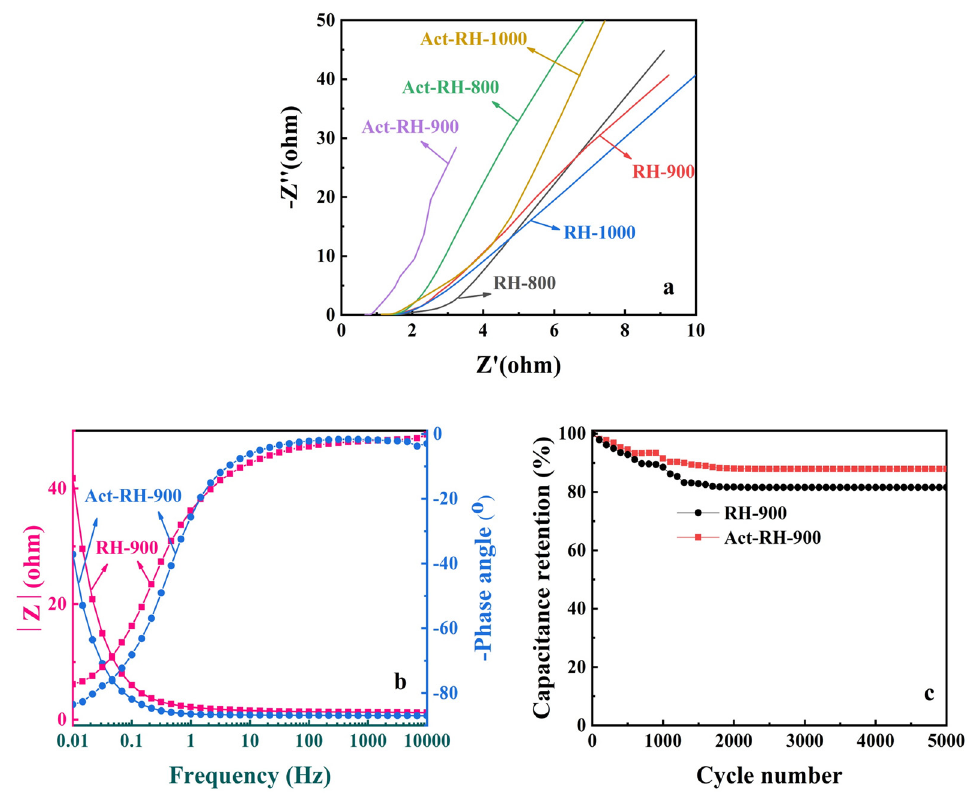
Figure 8. ( a ) EIS results for the investigated samples. ( b ) Bode phase angle and electrochemical impedance plots of RH-900 and Act-RH-900. ( c ) Capacitance retention of RH-900 and Act-RH-900 over 5000 cycles.